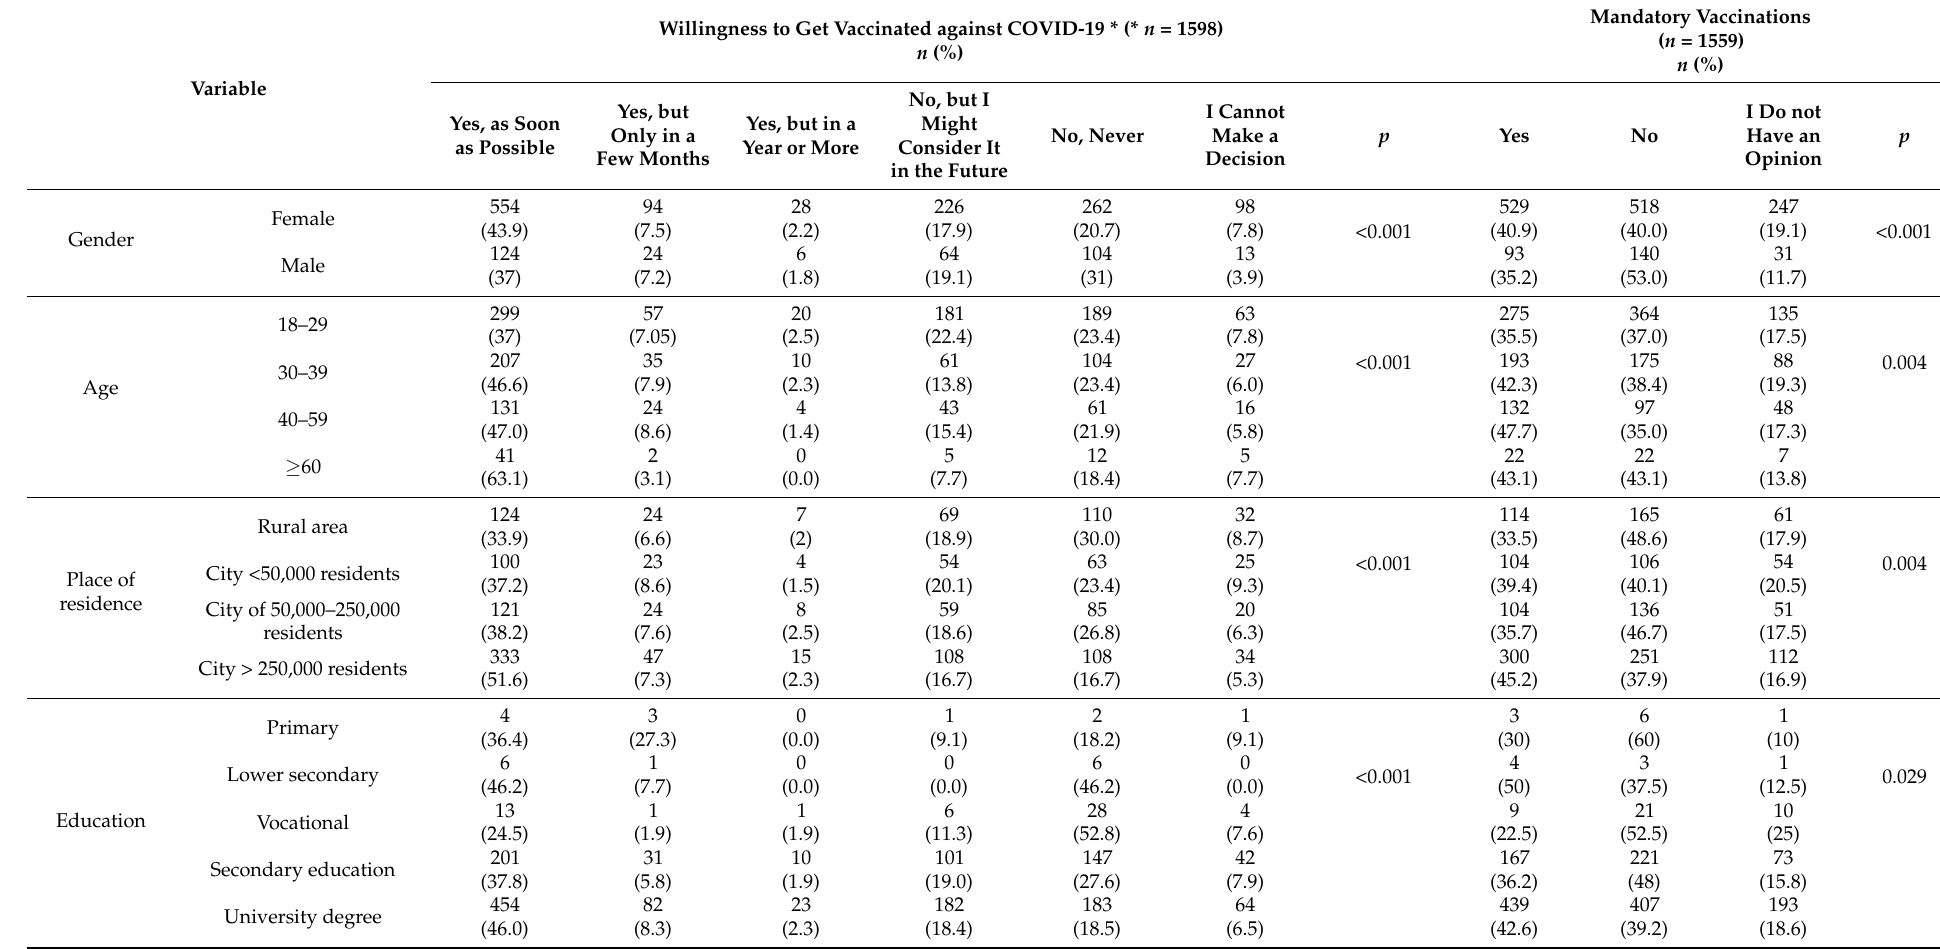
Table 3. Attitudes toward vaccination against COVID-19 concerning socio-demographic variables, types of vaccination, past medical history including COVID-19.